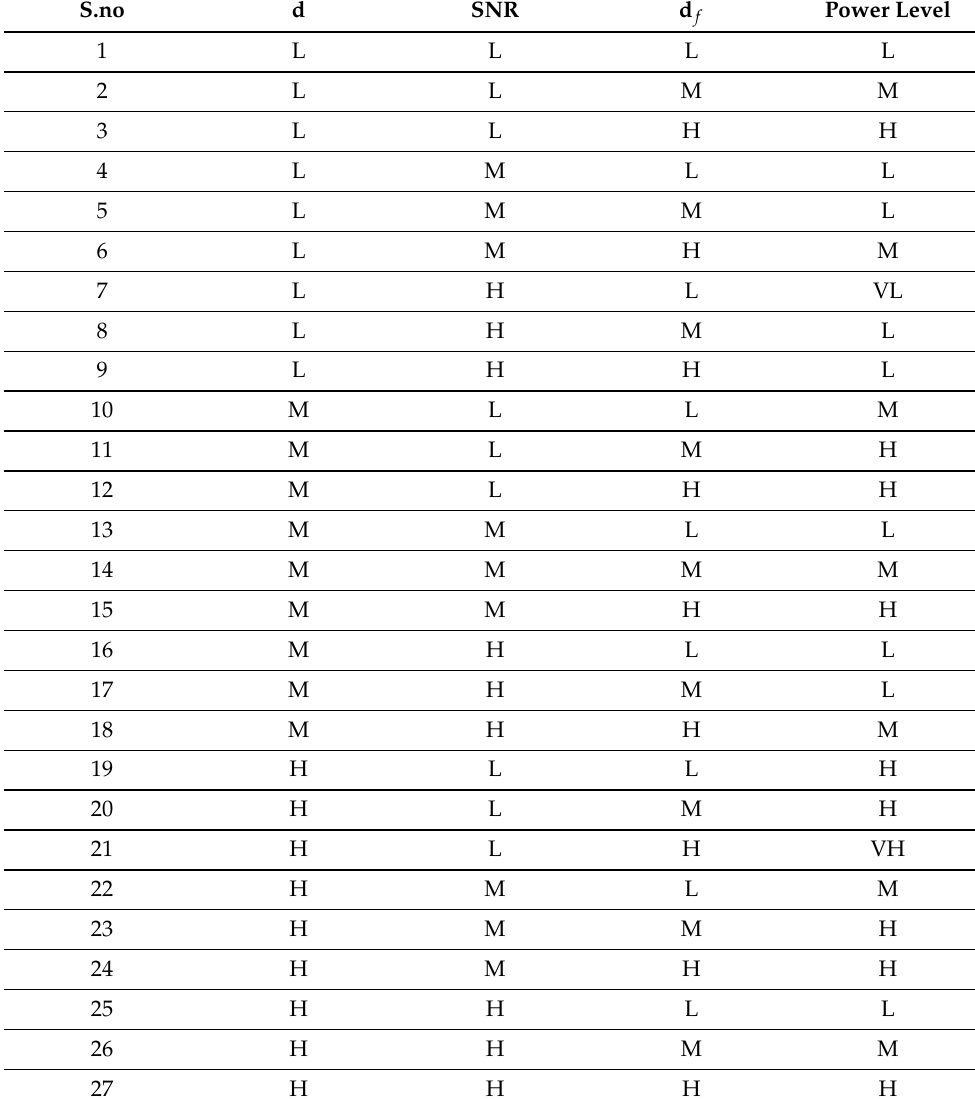
Table 1. Human Intuition based FIS system for Optimal PA in